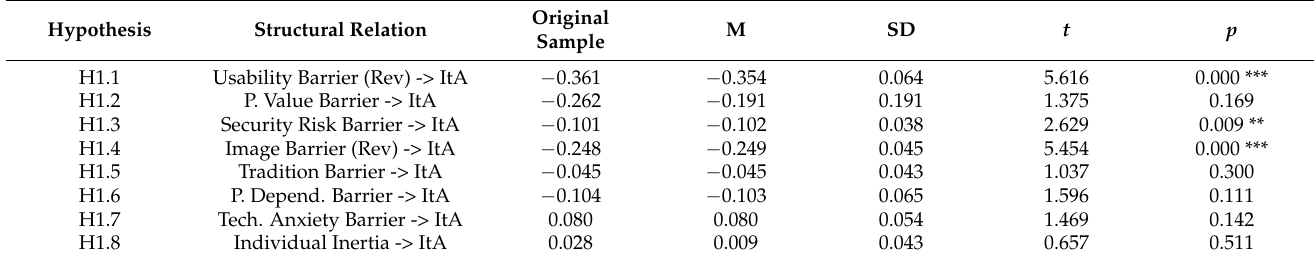
Table 3. Results from hypothesis H1 set about adoption